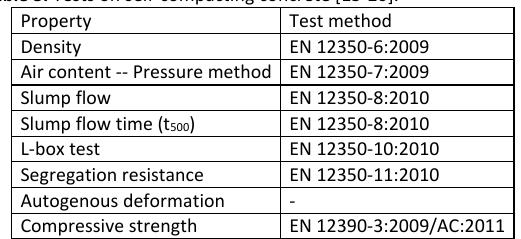
Table 3. Tests on self ‐ compacting concrete [15 ‐